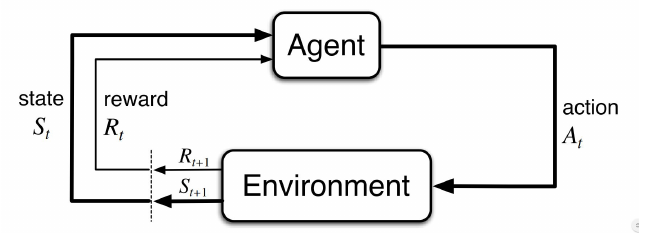
Figure 2. Block diagram of the Agent-Environment interaction in a Markov Decision Process